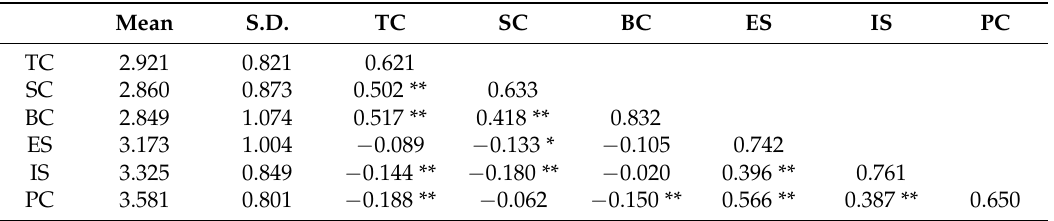
Table 5. Correlation analysis results.